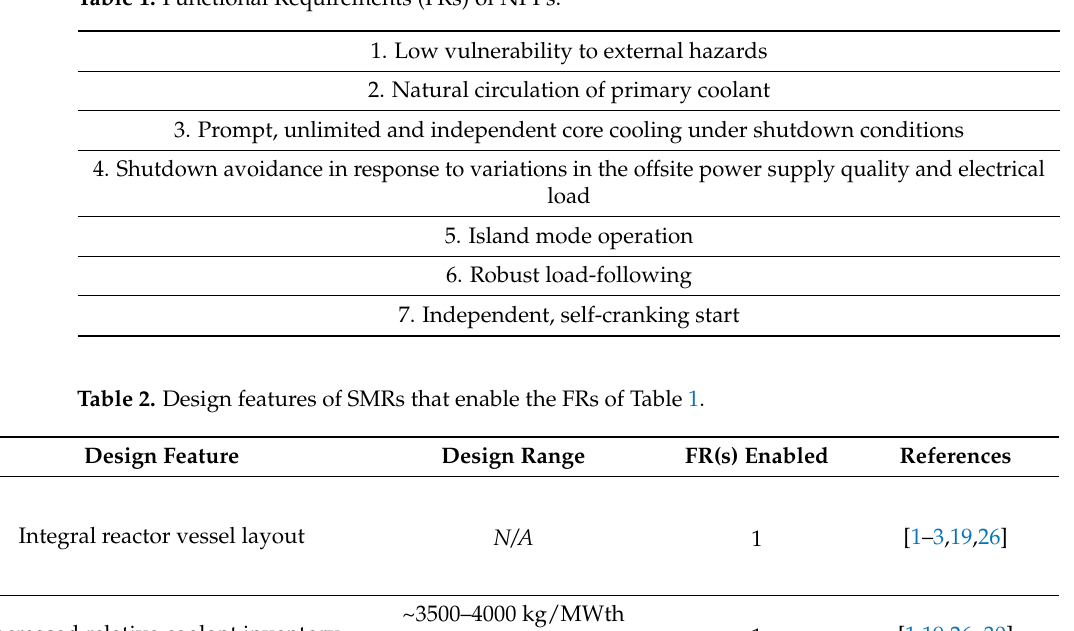
Table 1. Functional Requirements (FRs) of NPPs.